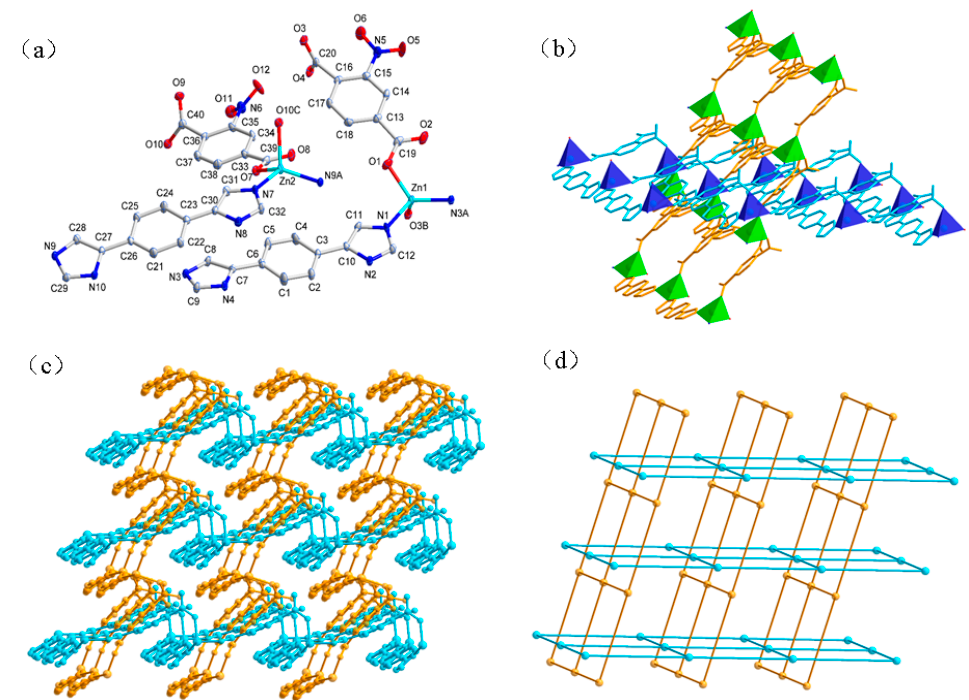
Figure 1. ( a ) The coordination environment of the Zn(II) atoms in 1 . Symmetry code: A x, 1 + y, 1 + z, B − 1 + x, y, z, C x, 1 + y, z. ( b ) 2D polycatenation of 1 . ( c ) The 3D framework built from 2D + 2D → 3D interpenetration. ( d ) Schematic representation of inclined interpenetration in 1 .